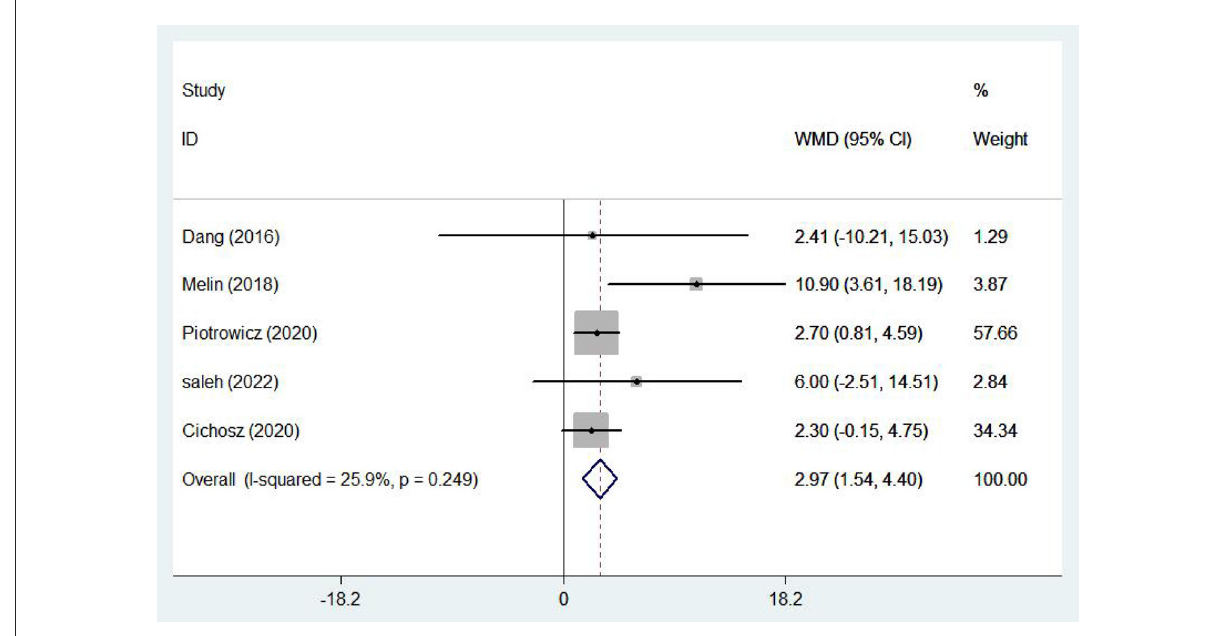
FIGURE10 Forest plots showing the effects of SF-36.